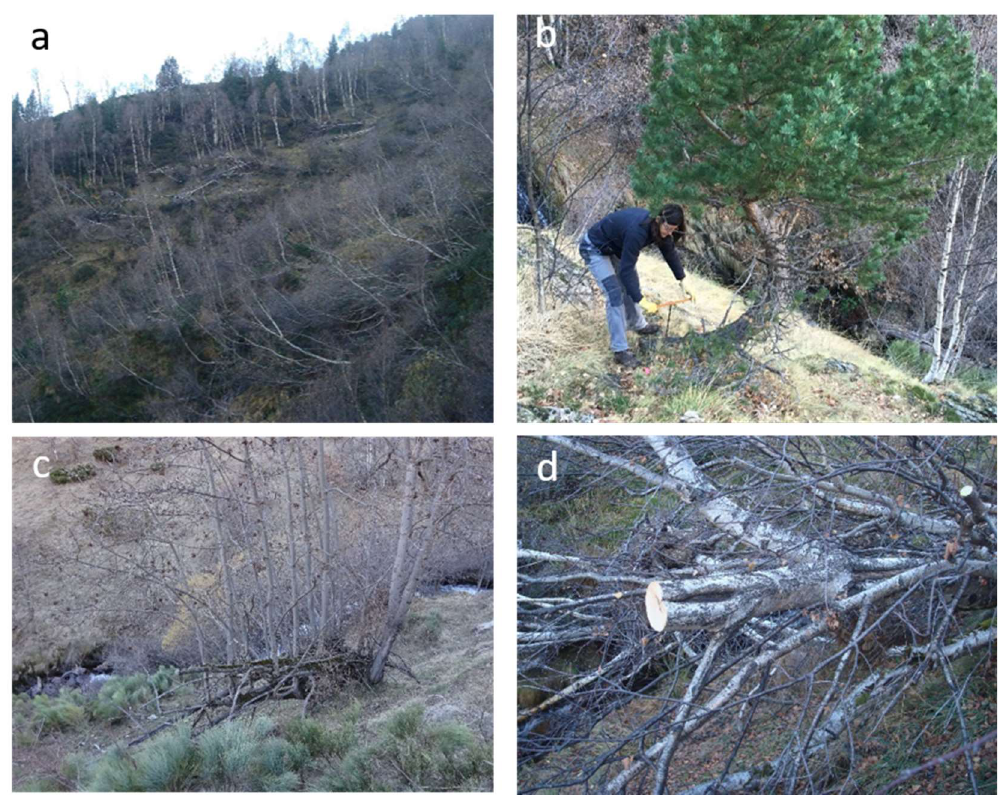
Figure 4. Tree shapes selected for dendrogeomorphological analysis: ( a ) Birches affected by a recent event in 2013–14 with leaning straight stems (upper section of photograph), and by an older event in 1995–1996 with curved stems (lower section of photograph); ( b ) pine tree with curved stem (tree 21); ( c ) ash tree with horizontal stems and post-event grown vertical stems (tree 17); ( d ) birch with scarred, leaning stem (tree 13). See tree numbering in Figure 11.